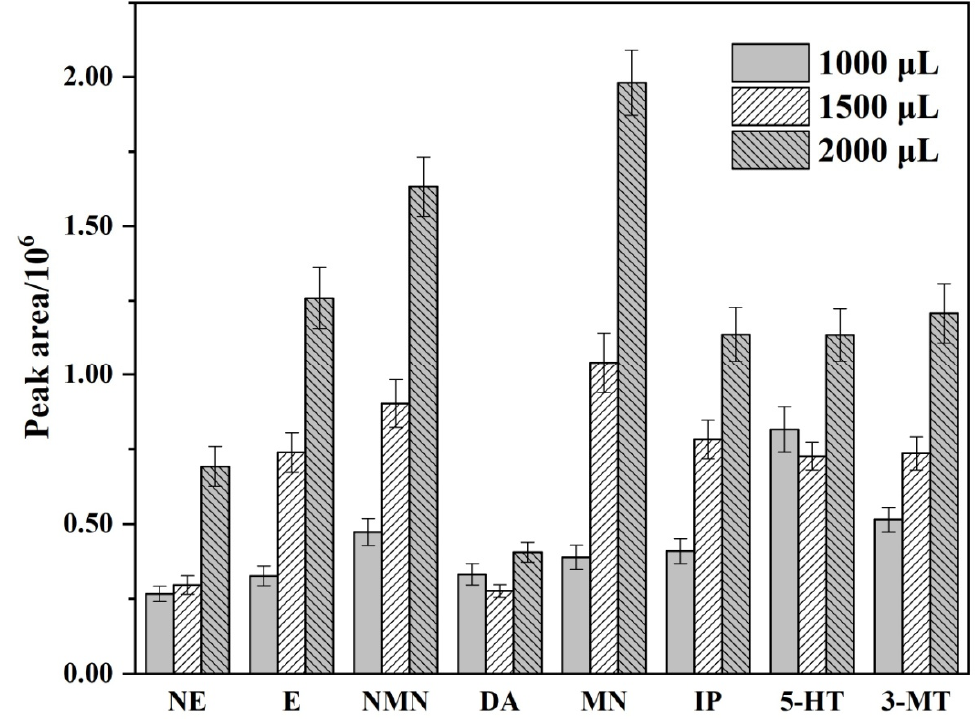
Figure 4. Comparison of peak area of the biogenic monoamines at different injection volume.